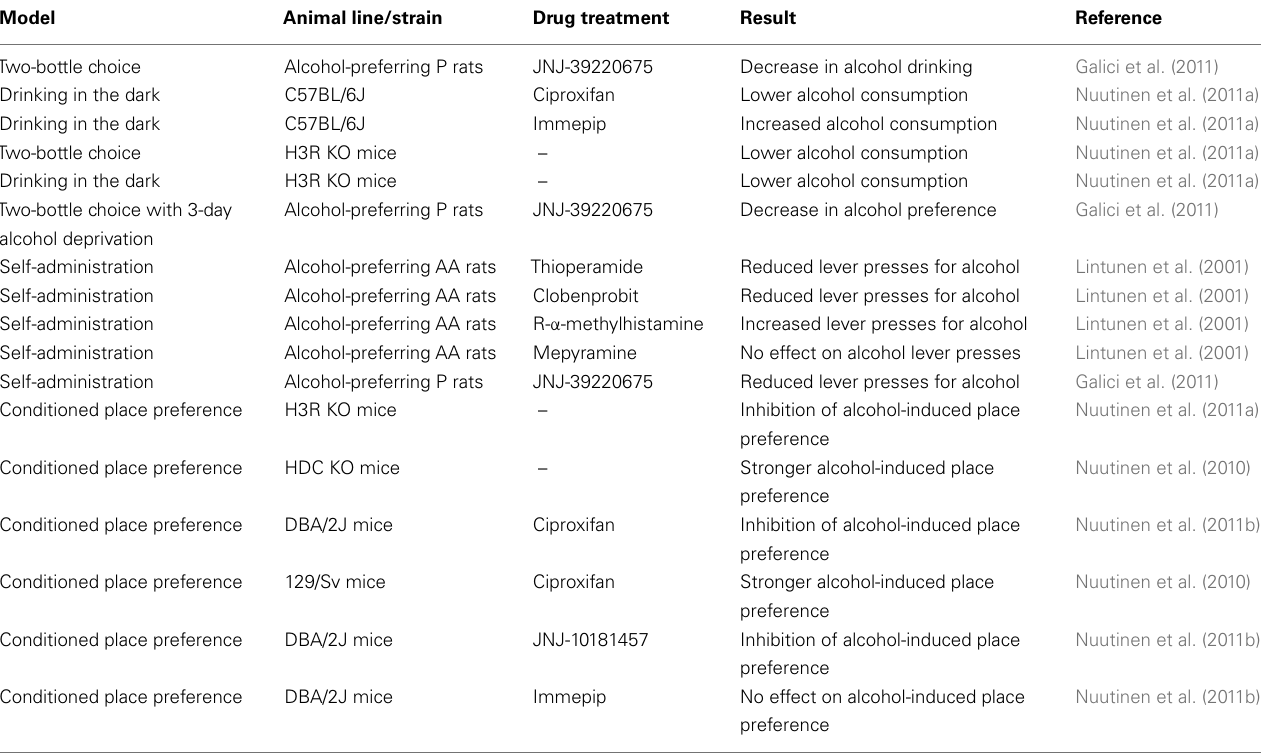
Table 1 | Summary of the alterations in alcohol consumption and reward followed by manipulations of the brain histaminergic